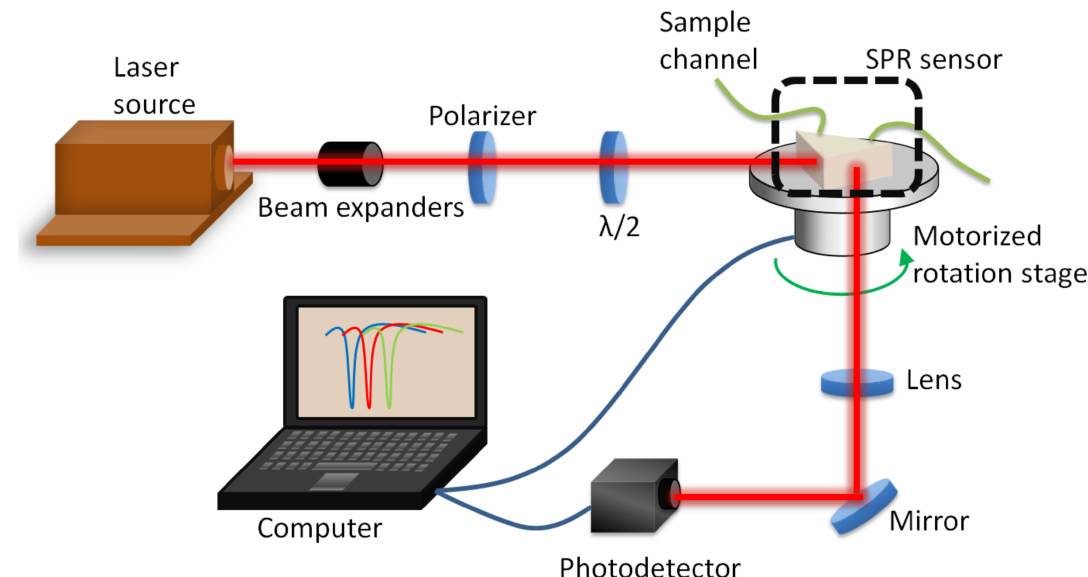
Figure 11. Schematic diagram of the experimental setup for SPR